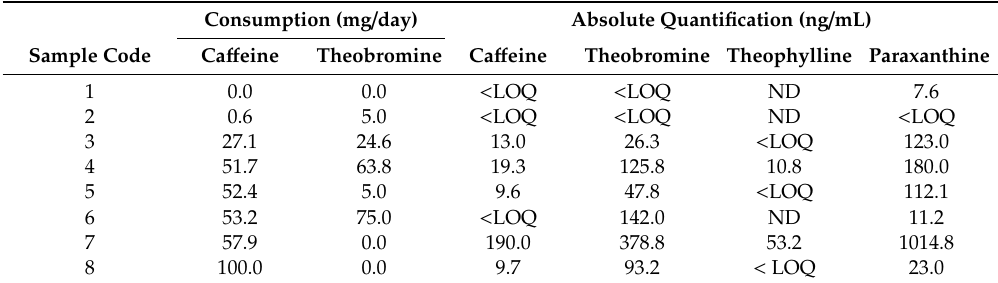
Table 4. Caffeine, theobromine, theophylline and paraxanthine quantification by LC-MS/MS in plasma human samples.